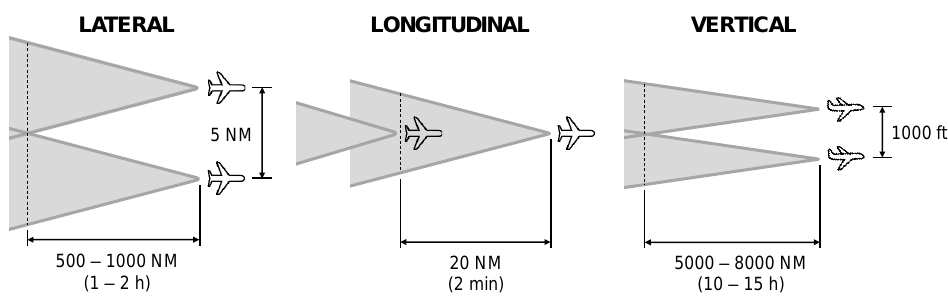
Figure 9. Lateral, longitudinal and vertical maximum plume overlap scenarios, based on nominal separation minima